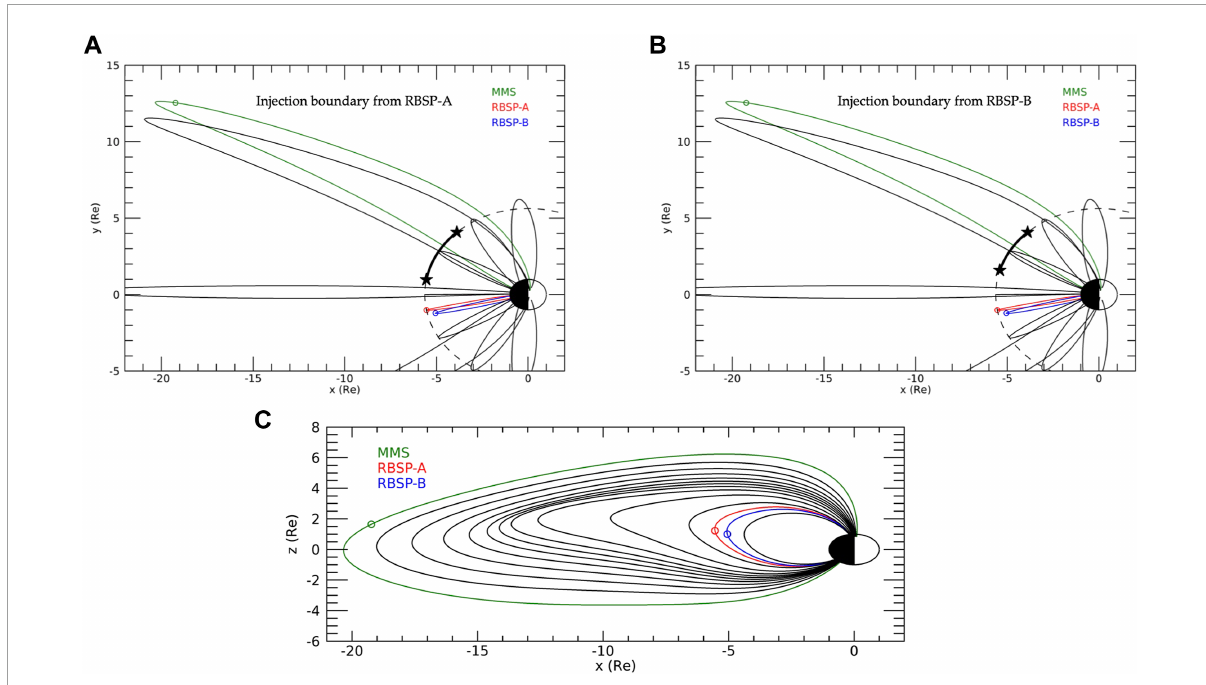
FIGURE 6 A map of the injection from the 15 August 2018 case study made in the (A,B) x-y and (C) x-z planes in GSM coordinates. The green, red, and blue circles are the locations of MMS, RBSP-A, and RBSP-B respectively at 12:00 UT. The estimated electron injection boundary as determined by (A) RBSP-A and (B) RBSP-B and ion injection boundary as determined by GOES-14 are given by the stars. The solid line connecting the two stars is an estimate for the region where the injection takes place. These were made using the IRBEM library (Boscher et al., 2004-2008) using the Tsyganenko 1996 magnetic field model (Tsyganenko,